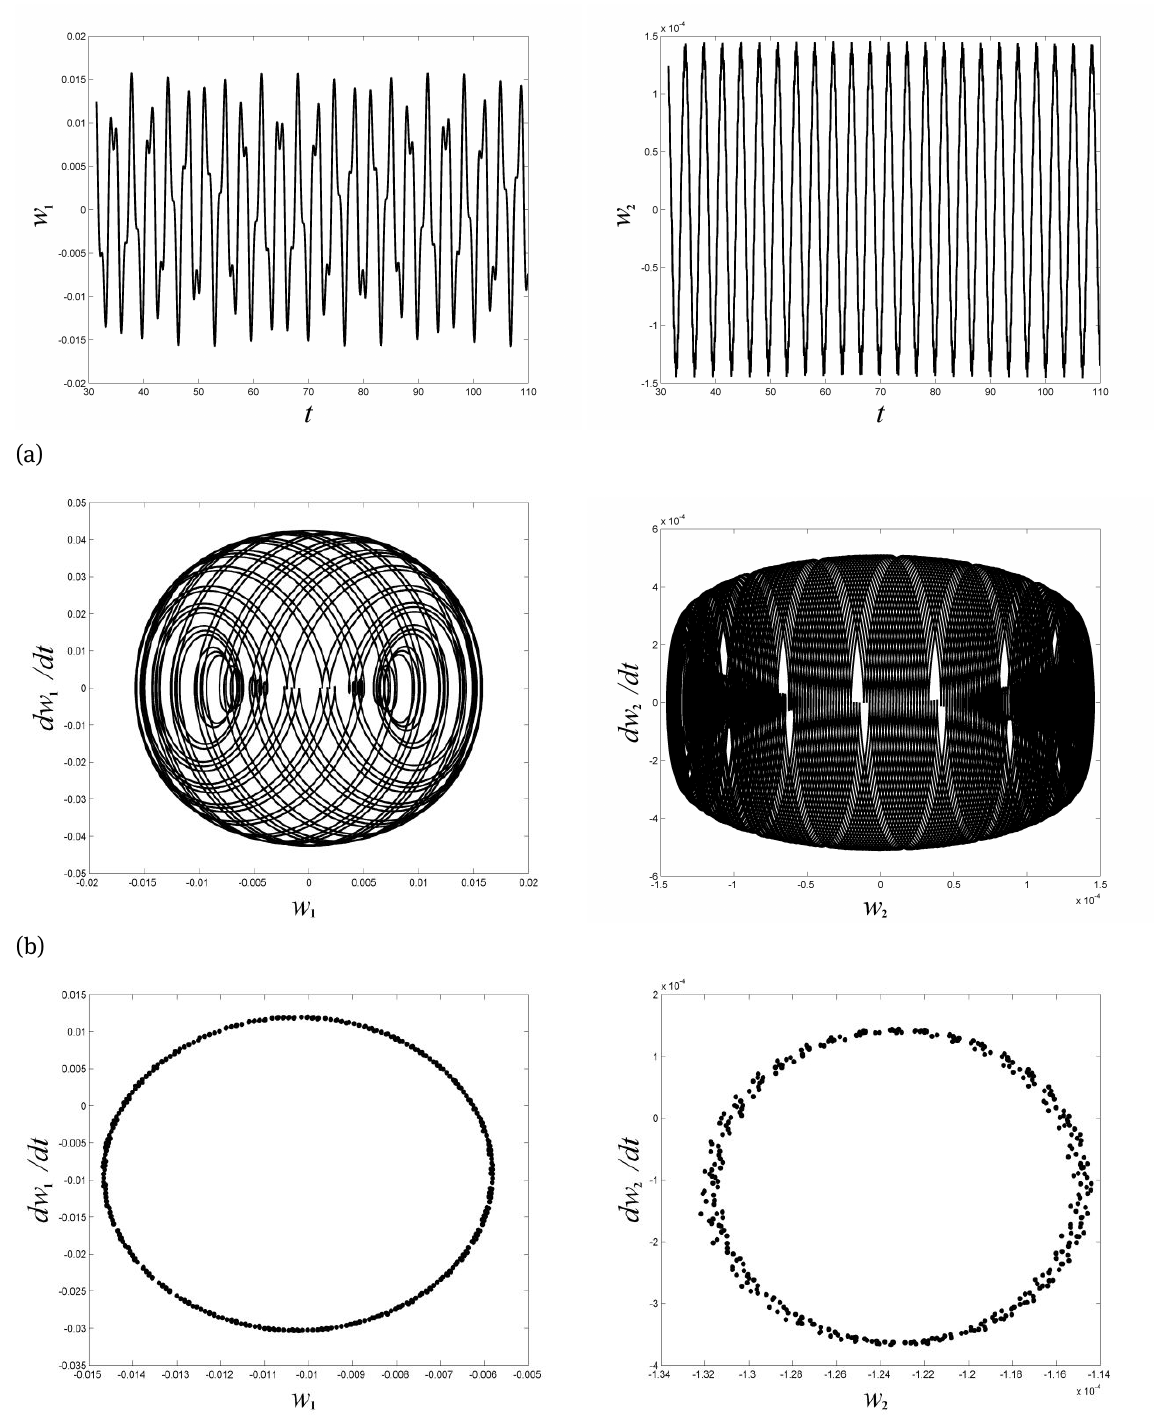
Fig. 3. Quasiperiodic behaviors of the cantilever beam system shown in wave diagrams (a), phase diagrams (b) and Poincaré maps (c). q = 50sin(20 πt )( Pa ) and e c = 3.28 × e 9 (cid:0) N / Nm 2 (cid:1)